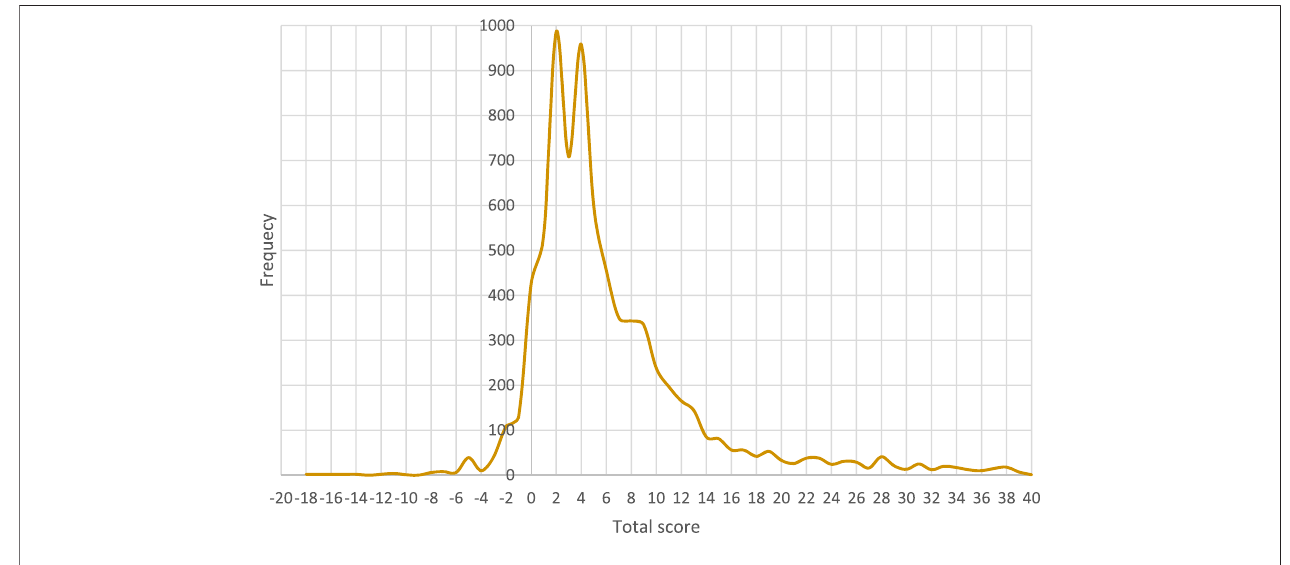
FIGURE 14 | Sentiment score distribution of all words in carbon neutrality